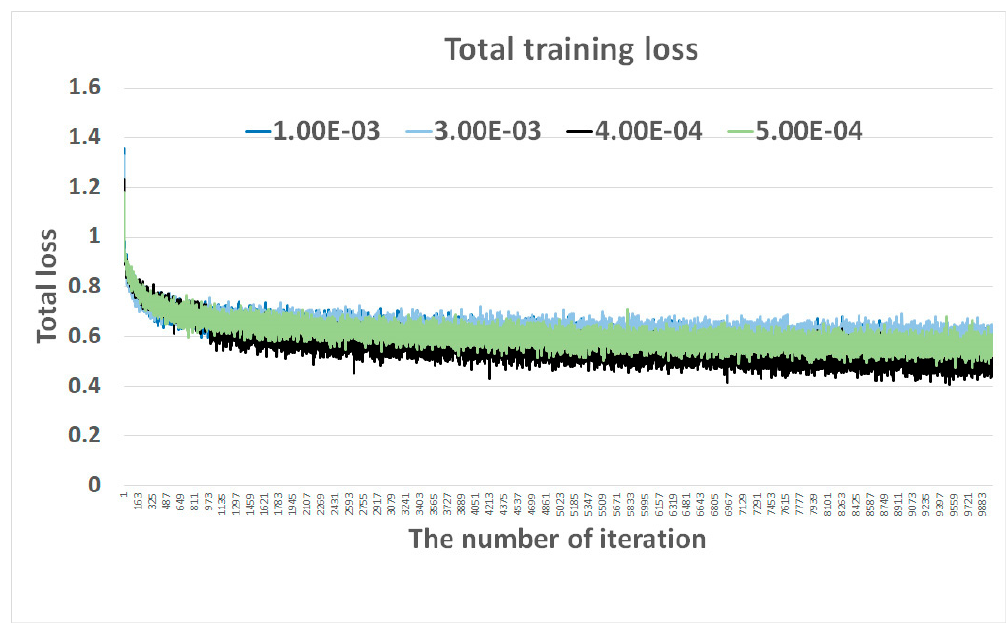
Figure 3. Total training loss comparison in the logarithm space of four different learning rates to optimize the base learning rate.